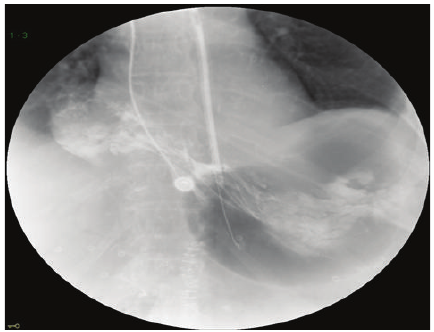
Figure 4: Upper GI series showing NG tube delivering contrast into stomach and supradiaphragmatic antrum. Note that contrast does not flow out of the